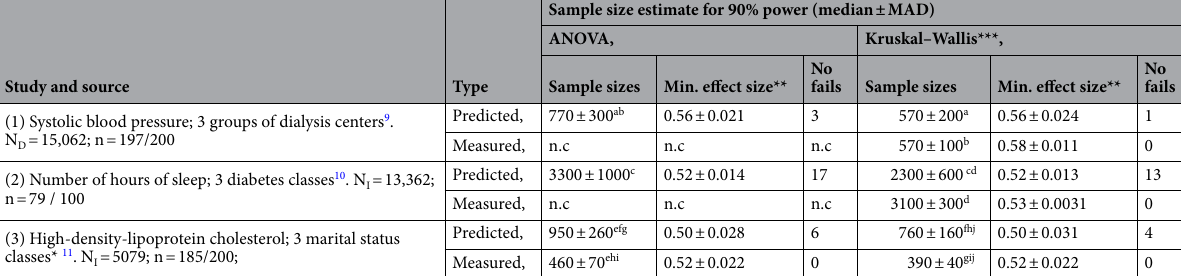
Table 4. Predicted and measured Monte-Carlo sample sizes for 90% power using ANOVA or Kruskal-Wallis tests, using samples derived from Medical study result datasets. ANOVA Analysis of variance, MAD Median absolute deviation; Min. = minimum; No. fails = number of failures; Predicted: sample sizes with 90% power from predicted fits created from initial samples with (arbitrarily) approximately one third sample size. Measured: sample sizes with power measured at 90% from data randomly selected from datasets at increasing sample size. n = number of times prediction or measurement carried out. N D = number of dialysis treatments; N I = number of individuals. All results to two significant figures. Brown-Mood median test (R [coin] median_ test ) global values (2 df): (1) chi 2 = 29.4, p = 4.07 × 10 −7 (2) chi 2 = 9.13, p = 0.0104 (3) chi 2 = 506, p < 2.2 × 10 −16 ; Bonferroni-adjusted Brown-Mood median test comparisons with same letter significantly different at p < 0.05, other comparisons not significantly different: a Z = 3.46; p = 0.00171; b Z = 4.65, p = 1.00 × 10 −5 ; c Z = 3.65, p = 0.000263; d Z = 3.49, p = 0.00145; e Z = 13.6, p < 1.32 × 10 −15 ; f Z = 4.26, p = 0.000124; g Z = 18.2, p < 1.32 × 10 −15 ; h Z =− 12.8, p = < 1.32 × 10 −15 ; i Z = 7.38, p = 9.55 × 10 −13 ; j Z = 18.0, p < 1.32 × 10 −15 . *after Johnson